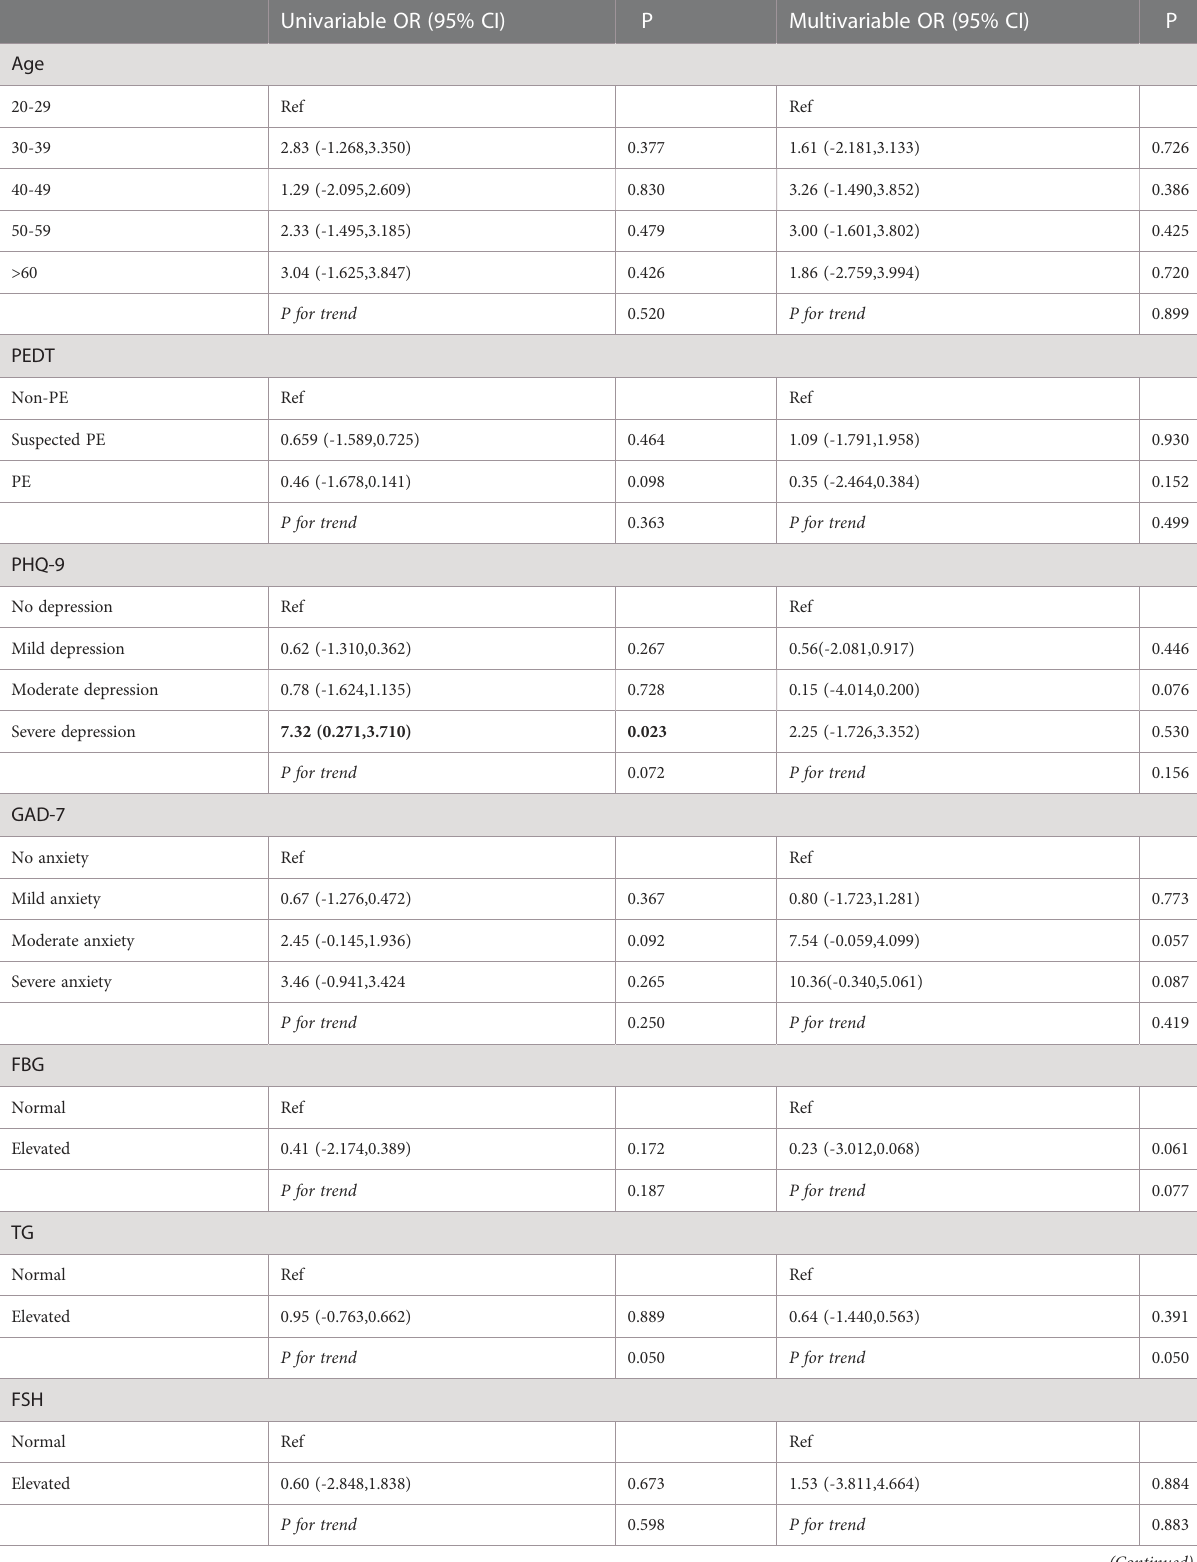
TABLE 4.1 Univariable and multivariable ordinal logistic regression analysis among DMED